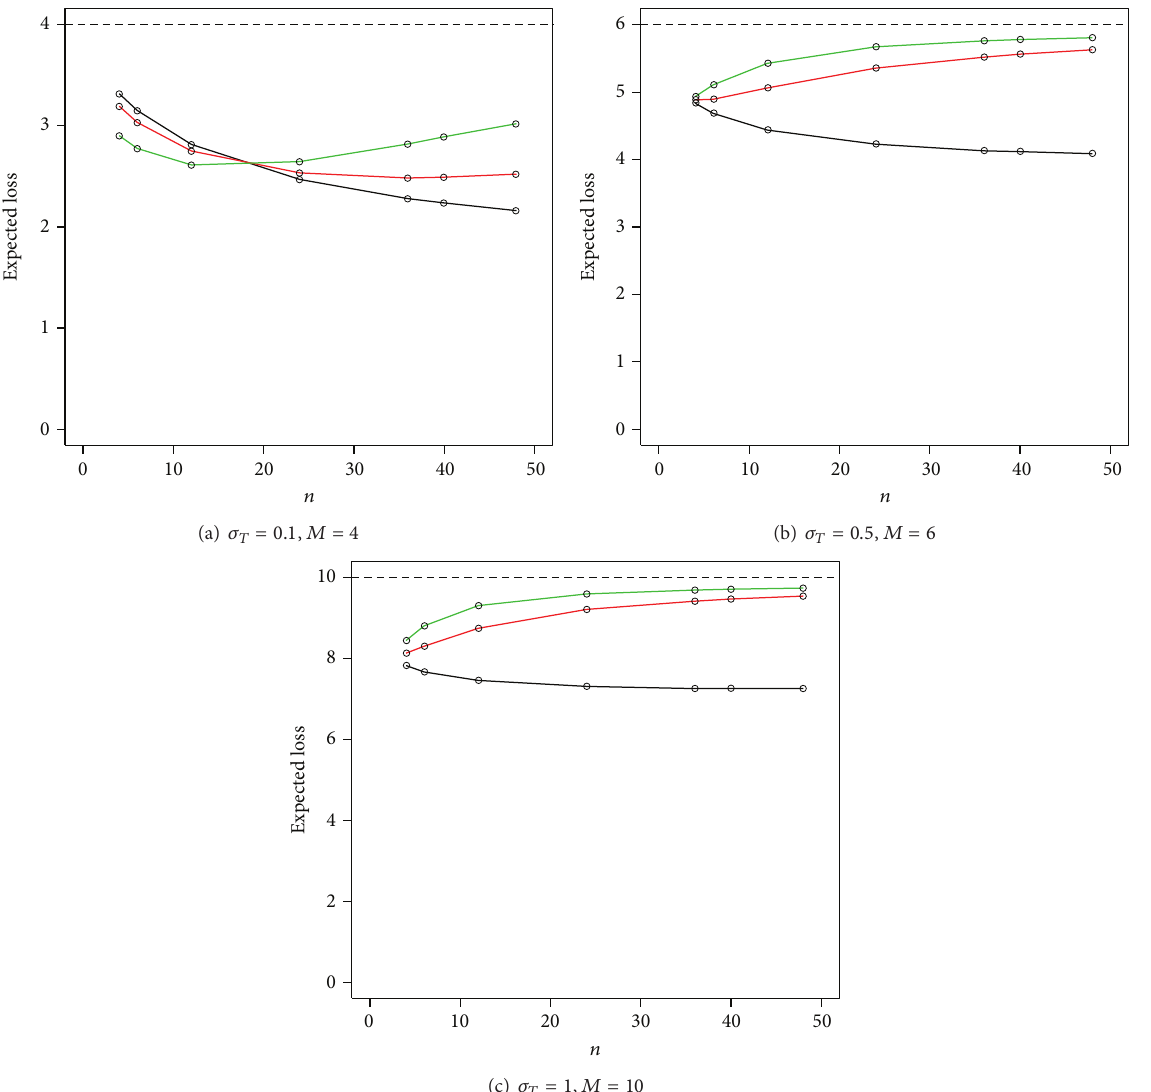
Figure 7: Expected loss for protracted threat using SITMUF joint cusum for 𝑛 = 4,6, 12, 24, 36, 40, 48 . (Colors black, red, and green correspond to Σ 1 – Σ 3 . Dashed lines are for